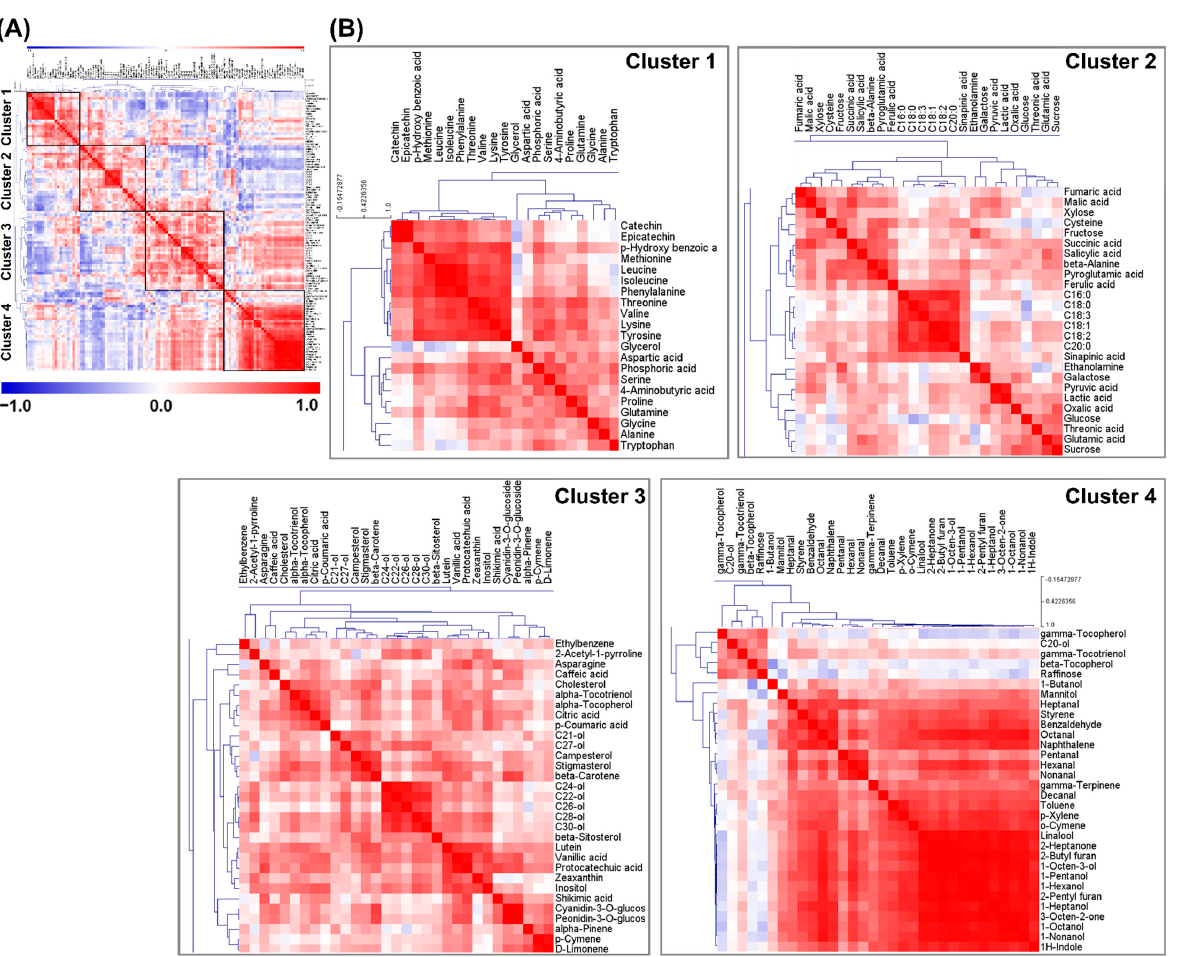
Figure 3. Correlation matrix and cluster analysis of data for 110 metabolites of black, red, and non-pigmented (white) rice cultivars ( A ). Detailed correlation matrix of each compound cluster ( B ). Each square indicates a Pearson’s correlation coefficient for a pair of compounds. The value for the correlation coefficient is represented by the intensity of the blue or red color, as indicated on the color scale. Hierarchical clusters are presented as a cluster tree. C20-ol, Eicosanol; C21-ol, Heneicosanol; C22-ol, Docosanol; C24-ol, Tetracosanol; C26-ol, Hexacosanol; C27-ol, Heptacosanol; C28-ol, Octacosanol; C30-ol, Triacontanol; C16:0, Palmitic acid; C18:0, Stearic acid; C18:1, Oleic acid; C18:2, Linoleic acid; C18:3, alpha-Linolenic acid; C20:0, Arachidic